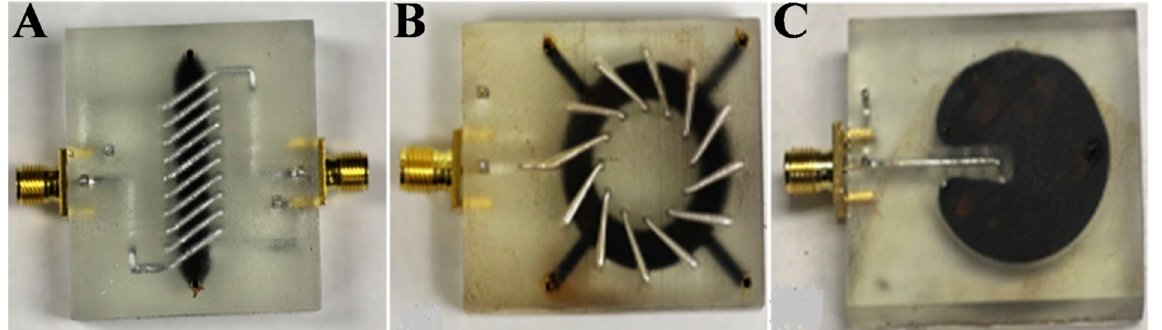
Figure 11. ( A ) FN-cored transformer; ( B ) FN − cored toroidal inductor; ( C ) planar coil − based inductive wireless power system with magnetic backplane using FN. Reprinted with permission from Ref. [107]. Copyright 2019, Elsevier.